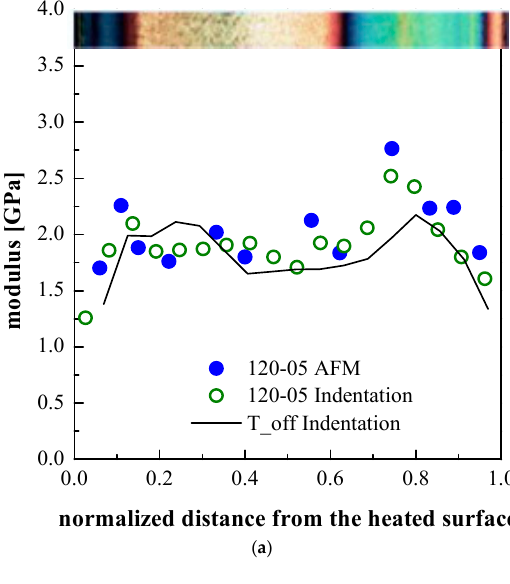
Figure 7. Load-displacement curves of three different positions along the thickness of sample 120-18.